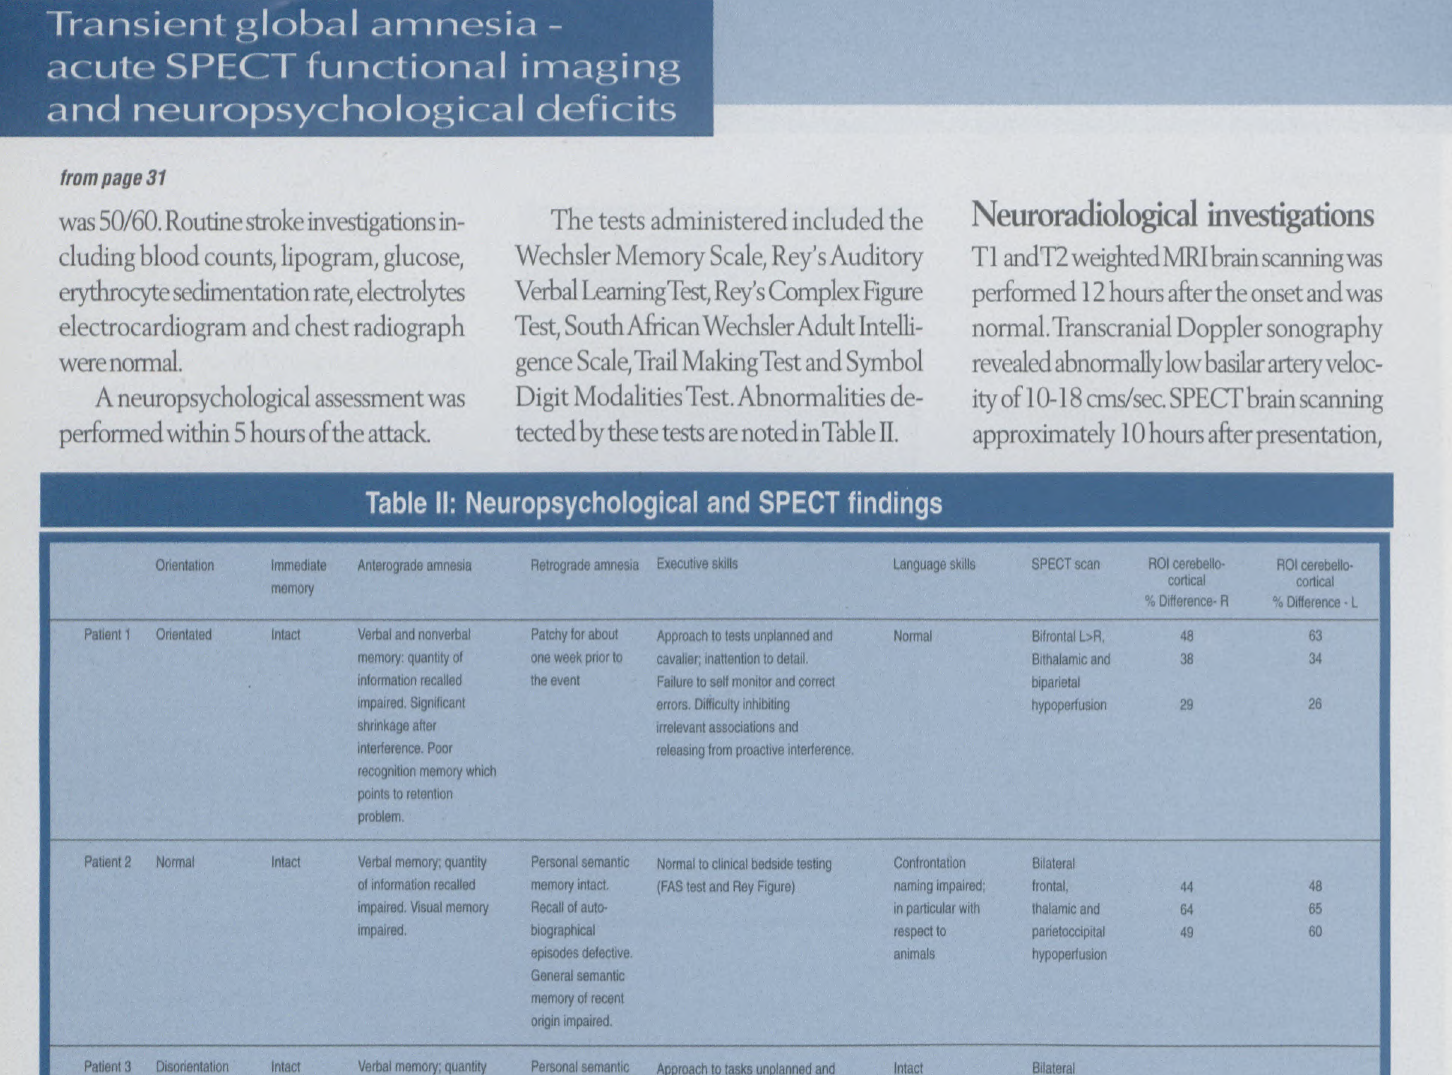
Table II: Neuropsychological and SPEeT